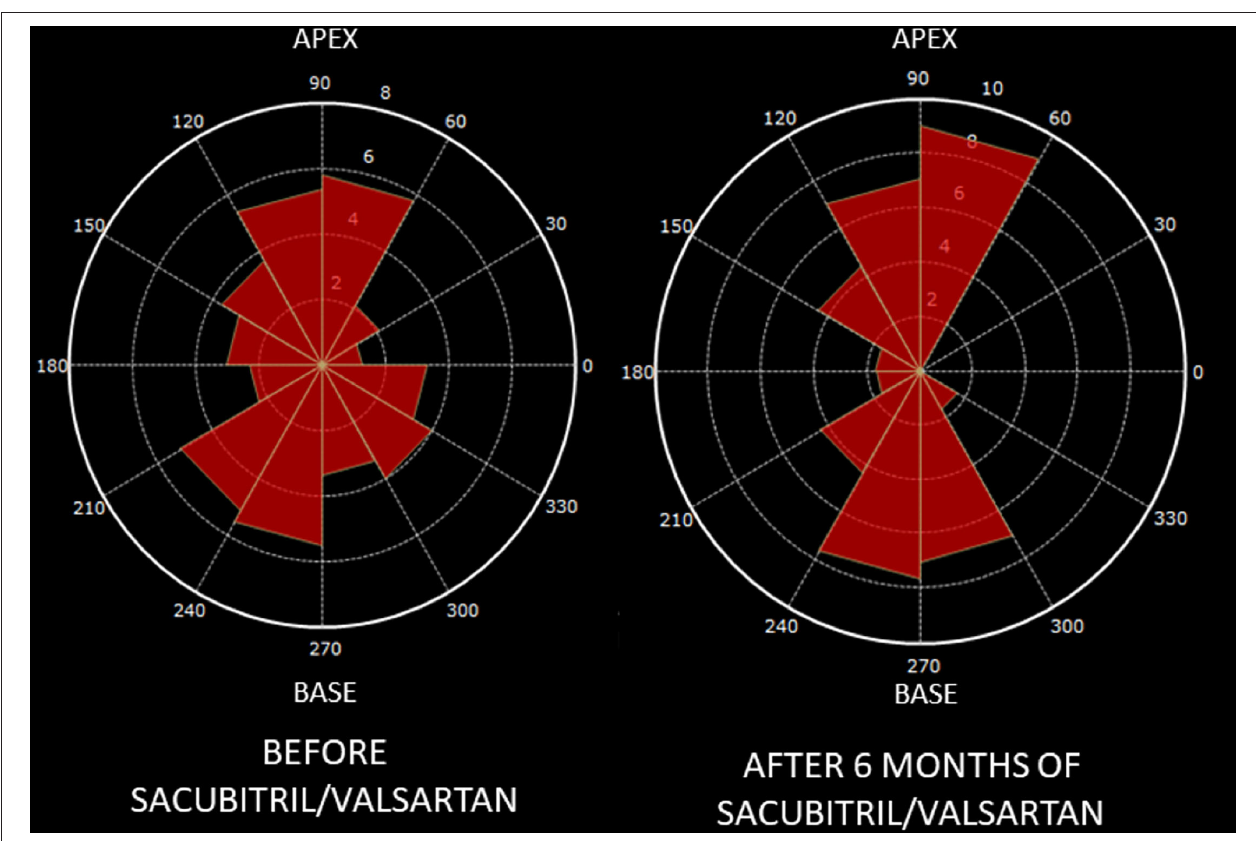
FIGURE 2 | Changes in hemodynamic forces distribution after Sacubitril-Valsartan. Graphic representation on a polar histogram of left ventricular hemodynamic forces (LV-HDFs) distribution in a patient: LV-HDFs distribution assessed over the entire cardiac cycle at baseline (left) and after 6 months of therapy with sacubitril-valsartan (right), showing a re-alignment of HDFs due to an improvement of longitudinal forces (apex to base, AB) over transversal ones (latero-septal, LS) and consequently a reduction of HDFs LS/AB ratio. AB, apex to base; HDFs, hemodynamic forces; LV, left ventricle; LS, latero-septal; LS/AB ratio, latero-septal over apex to base